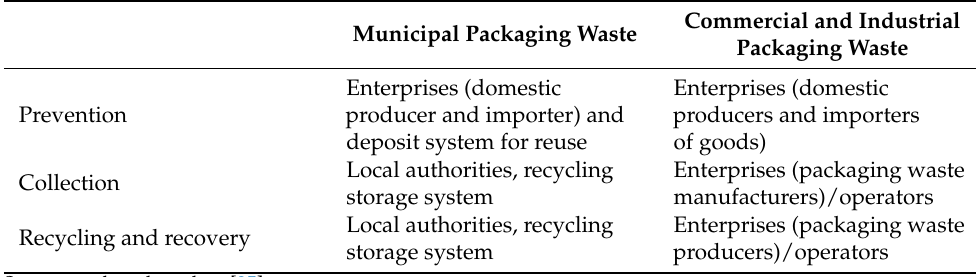
Table 6. Responsibilities for prevention, collection, recycling, and recovery in Denmark.